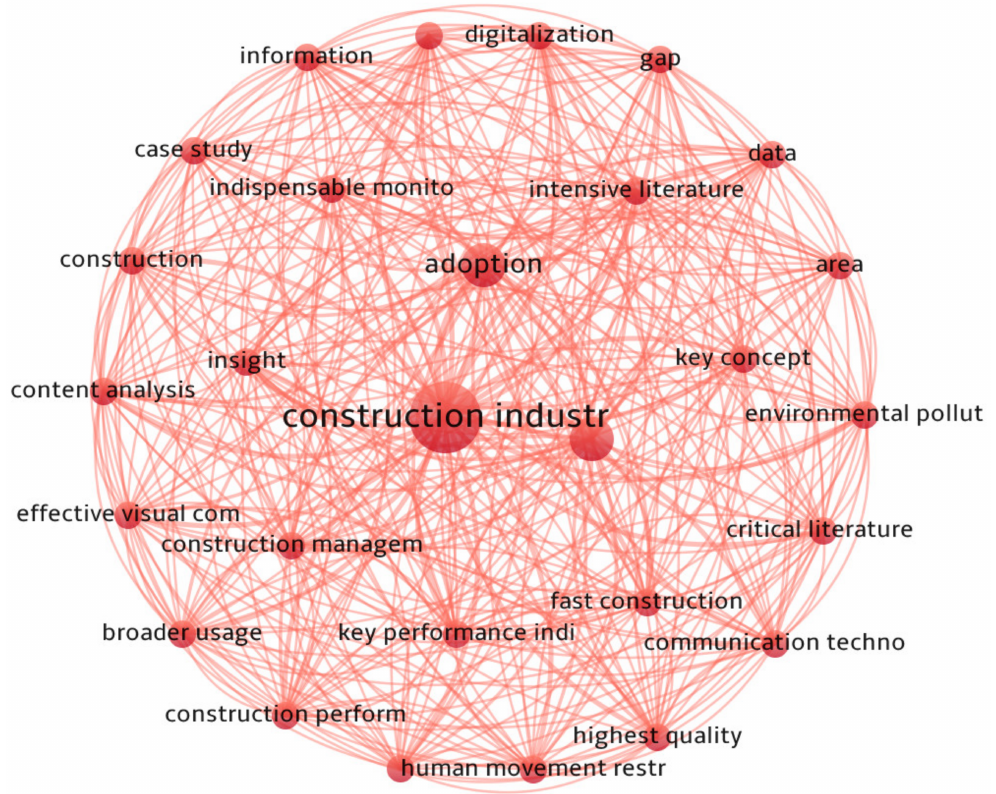
Figure 2. Keyword co-occurrence based on the included articles (60